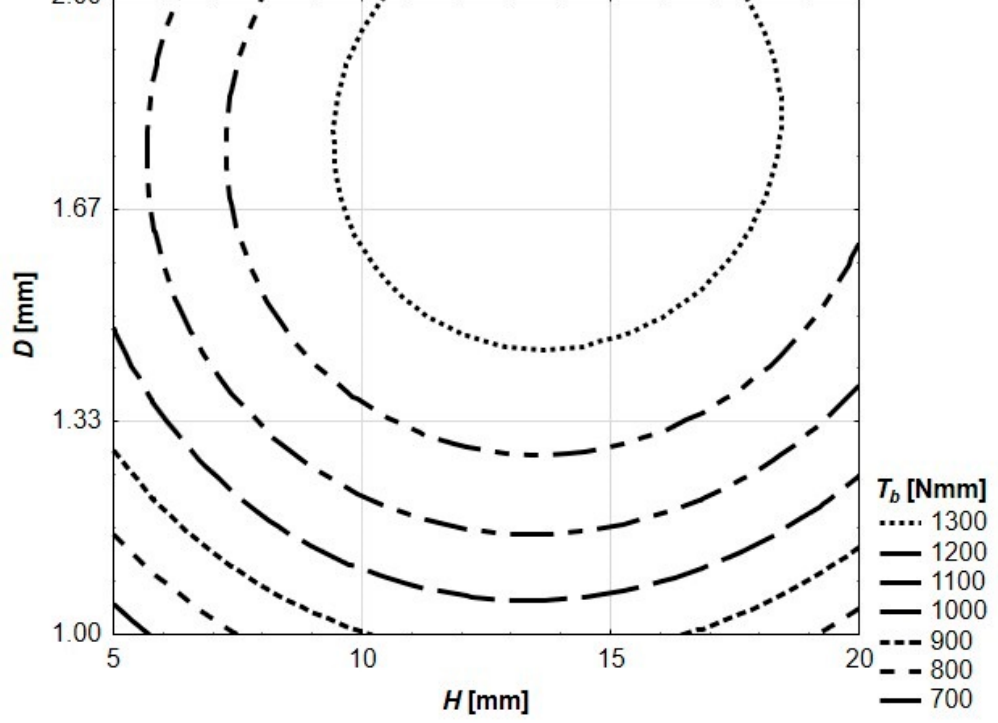
Figure 8. Flexural toughness of tested prism specimens for l /150.